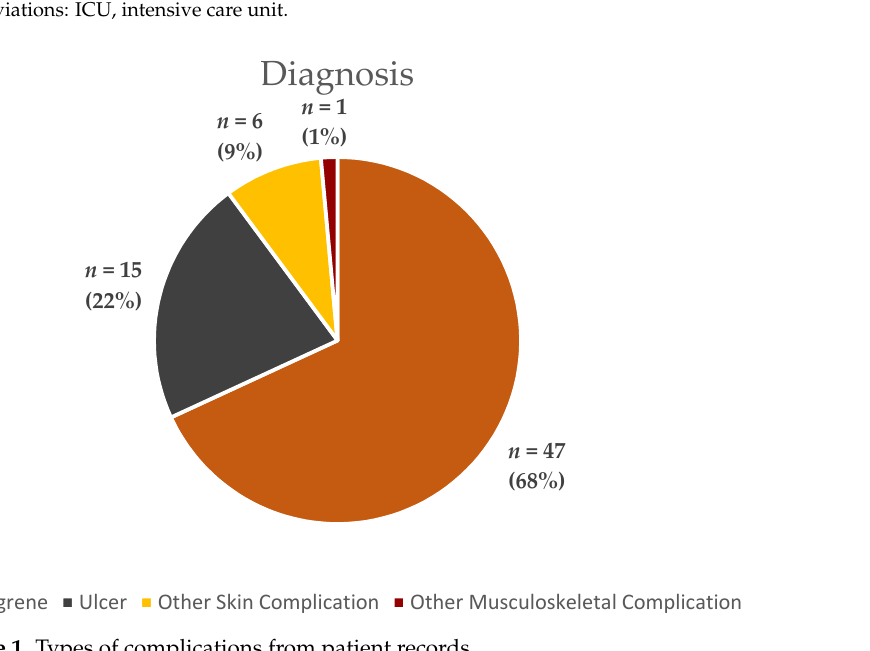
Figure 1. Types of complications from patient records.